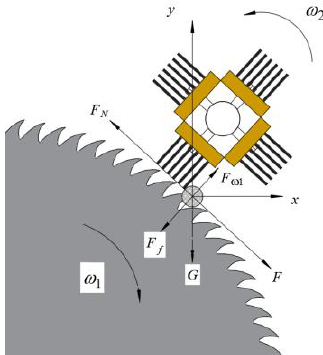
Figure 6. Force analysis of cotton. ω 1 and ω 2 are the rotational angular speed of the serrated disk and brush roller, respectively (rad/s); F f is the force of the serrated teeth on the cotton (N); F is the force of the brush roller on the cotton (N); θ is the angle between the force of the brush roller on the cotton and its own gravity (°); F 1 is the centrifugal force on the cotton (N); F N is the support force of the serrated teeth on the cotton (N); and G is the gravity of the cotton (N).